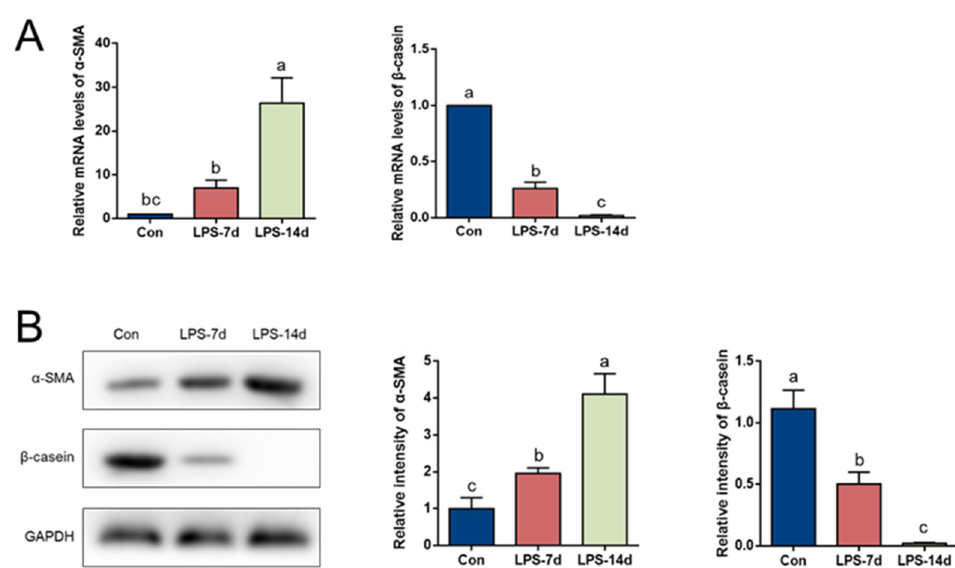
Figure A4. LPS altered the expression of α -SMA and β -casein in GMECs. ( A ) mRNA expression levels of α -SMA and β -casein. ( B ) Protein expression levels of α -SMA and β -casein. (original western blot figures in Figure S14). Different letters indicate significant differences between groups, p < 0.05.